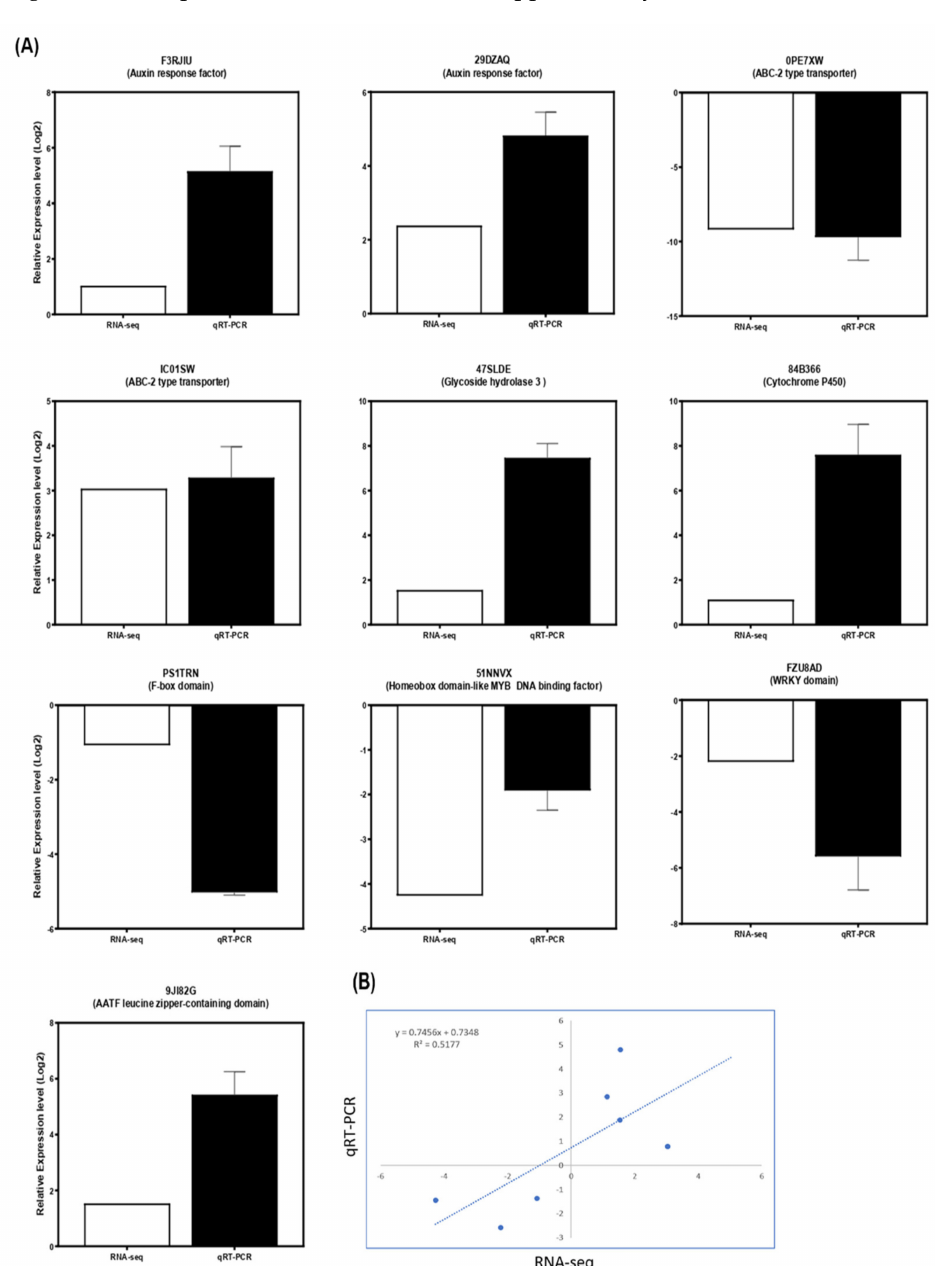
Figure 8. The quantitative real-time PCR analysis of DEGs identified during the onset of branch angle formation in prostrate and bunch-type peanut. ( A ) The expression level of 10 genes related to gravitropism, hormonal and signal transduction and transcription factors encoding genes was validated with qRT-PCR analysis and then compared with RNA-seq data. The data were presented as means of three independent biological replicates, and error bars denote ± SE ( n = 3). ( B ) The Pearson’s correlation coefficient of a liner regression of the transcripts level ratios between RNA-seq and qRT-PCR data. The correlation of the gene expression was calculated from RNA-seq data (x-axis) and qRT-PCR data